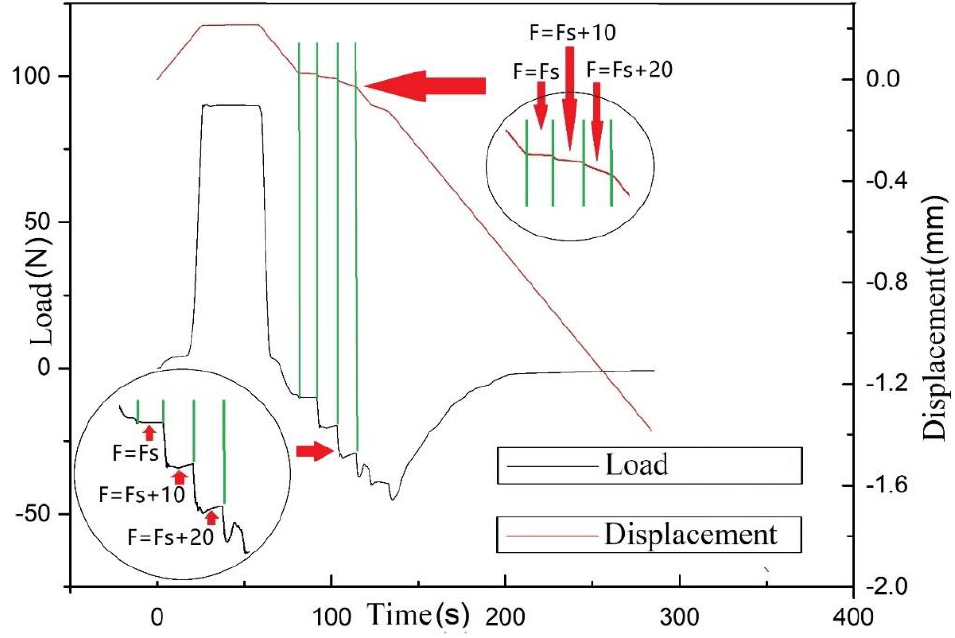
Figure 16. Constant tension test curve.